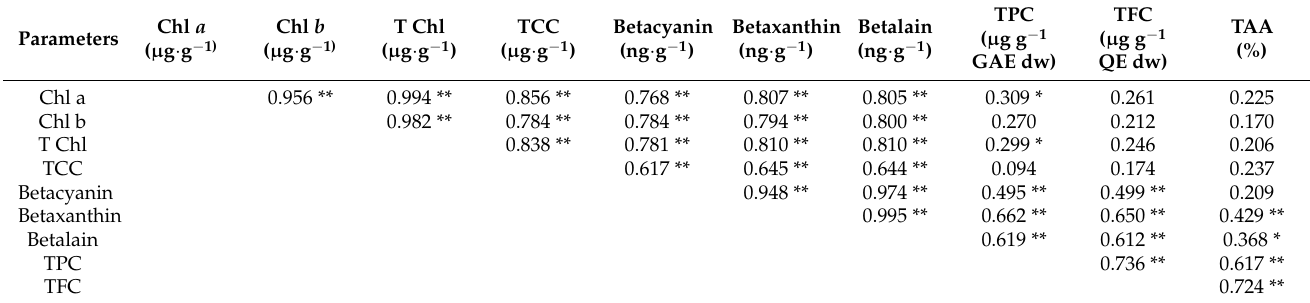
Table 5. Correlation coefficients for chlorophylls, total carotene contents, antioxidant leaf pigments, and TPCs, TFCs, and TAAs of four selected genotypes of A. lividus leafy vegetable under salinity